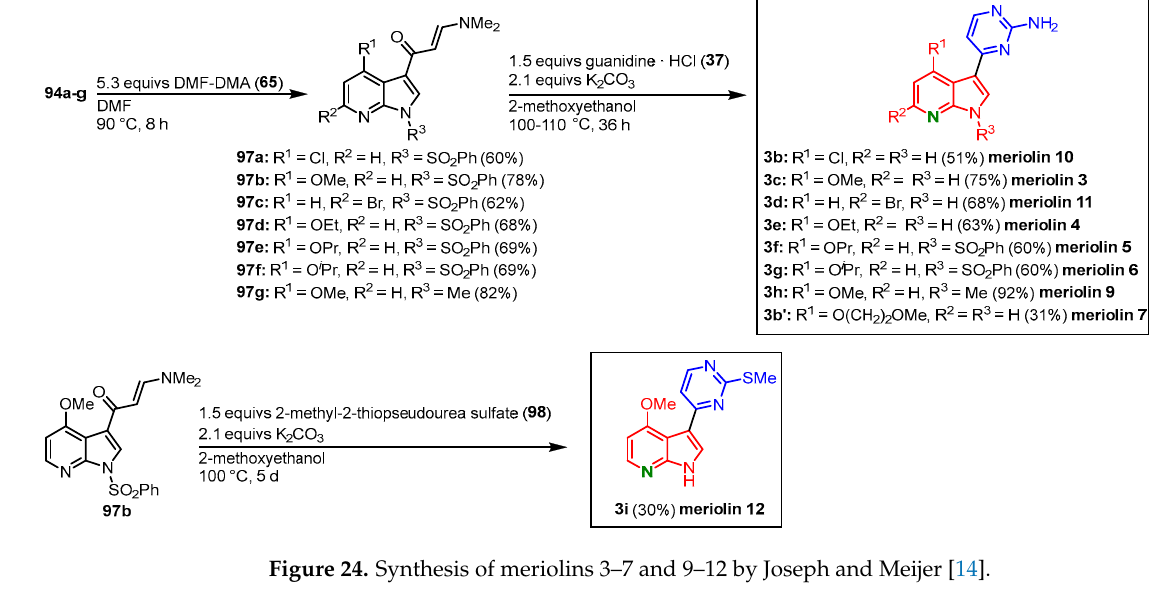
Figure 24. Synthesis of meriolins 3–7 and 9–12 by Joseph and Meijer [14].